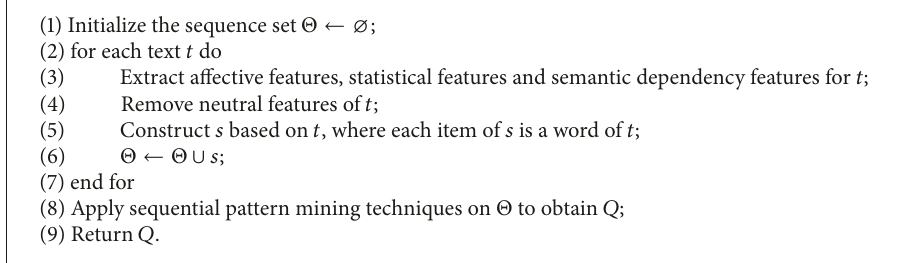
Algorithm 2: Mine word